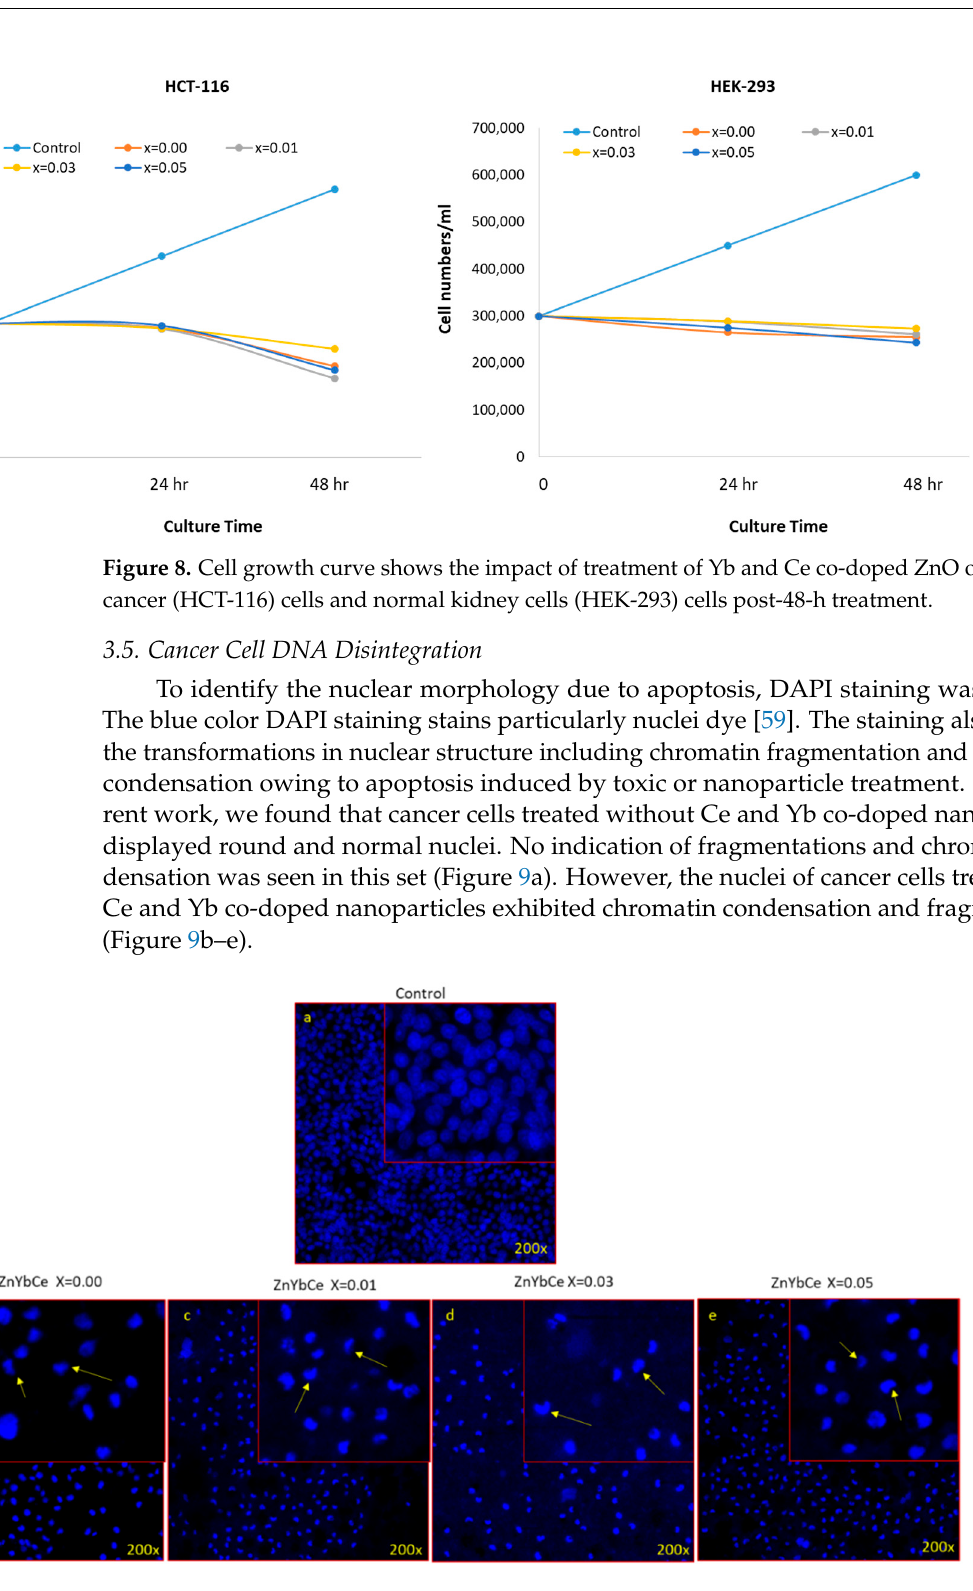
Figure 9. ( a – e ) Cancer cells morphology by DAPI staining. The impact of treatment with Yb and Ce co-doped ZnO NPs (x = 0.00, x = 0.01, x = 0.03, x = 0.05) on HCT-116 cells stained with DAPI post 48-h treatment. ( a ) (control) cell nucleus remains intact and normal, ( b – e ) are treated with nanoparticles. Images were taken by a fluorescence confocal microscope. The cells treated with nanoparticles showed chromatin condensation (arrows) which is the feature of apoptotic cell death.